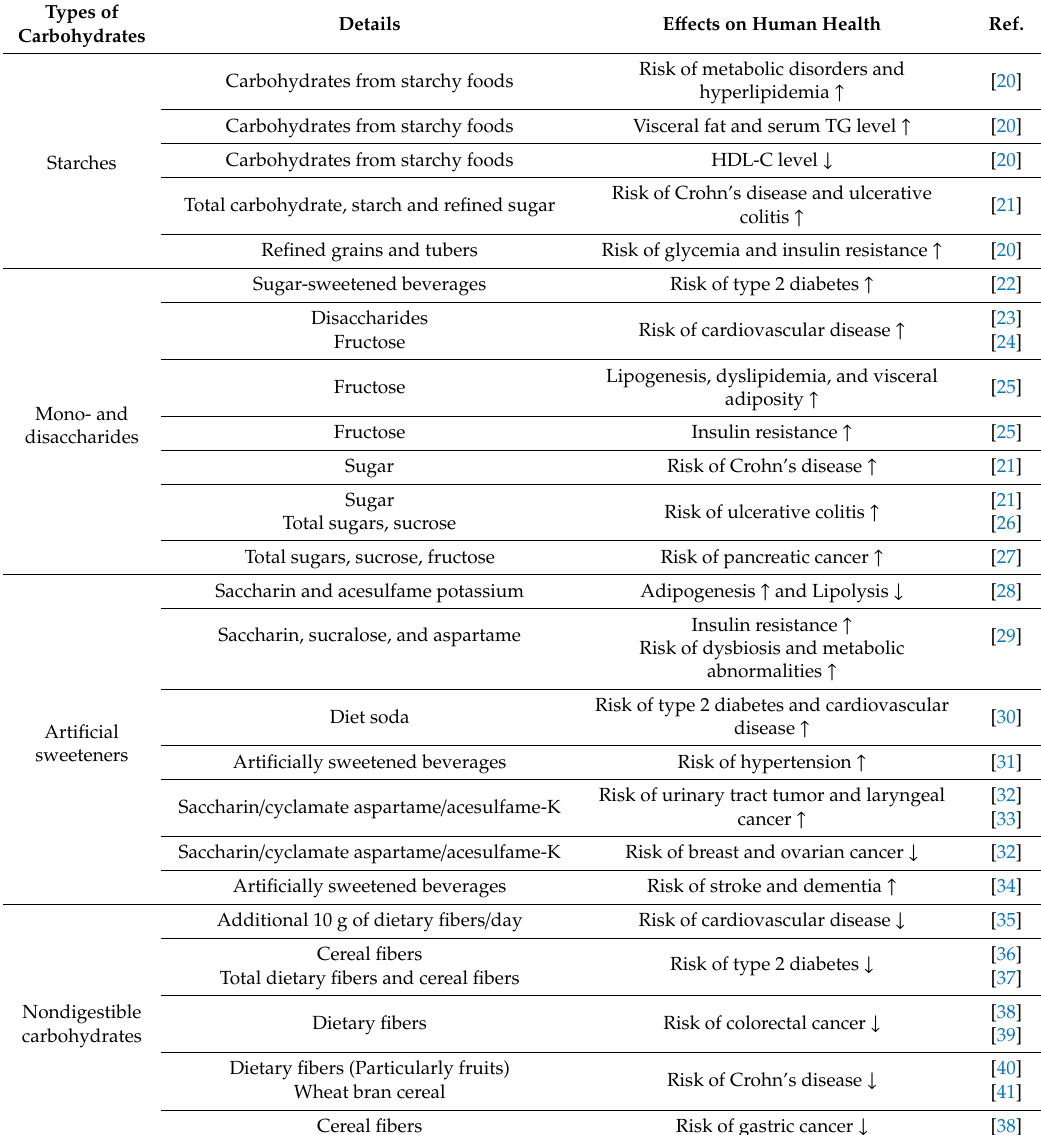
Table 1. Metabolic disorders associated with